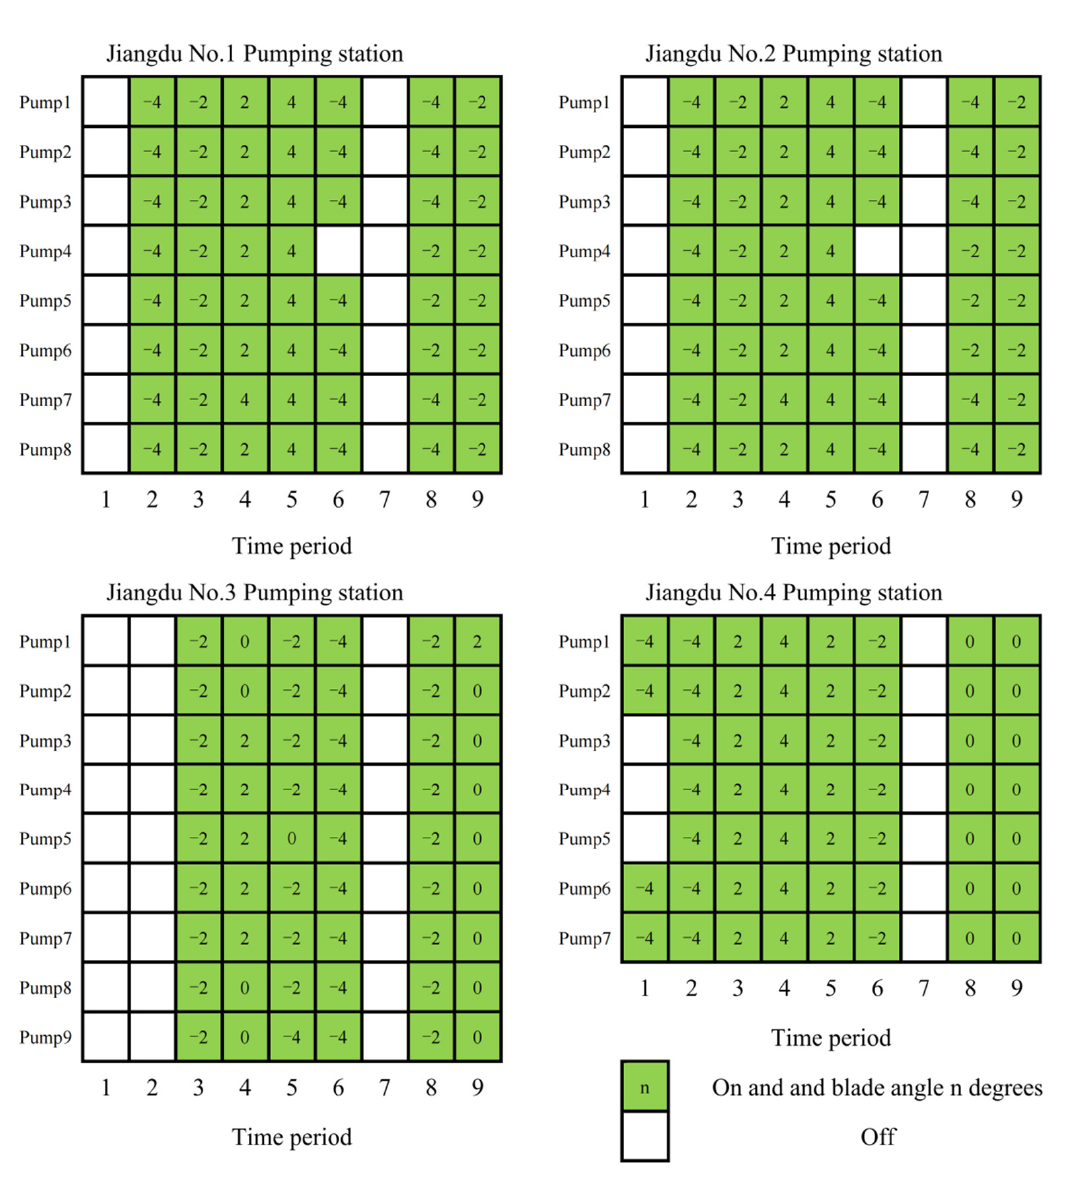
Figure 7. Optimal operation scheme of each pump unit in the Jiangdu parallel pumping station group under an average daily operation head of 7.8 m with 80% lift load.